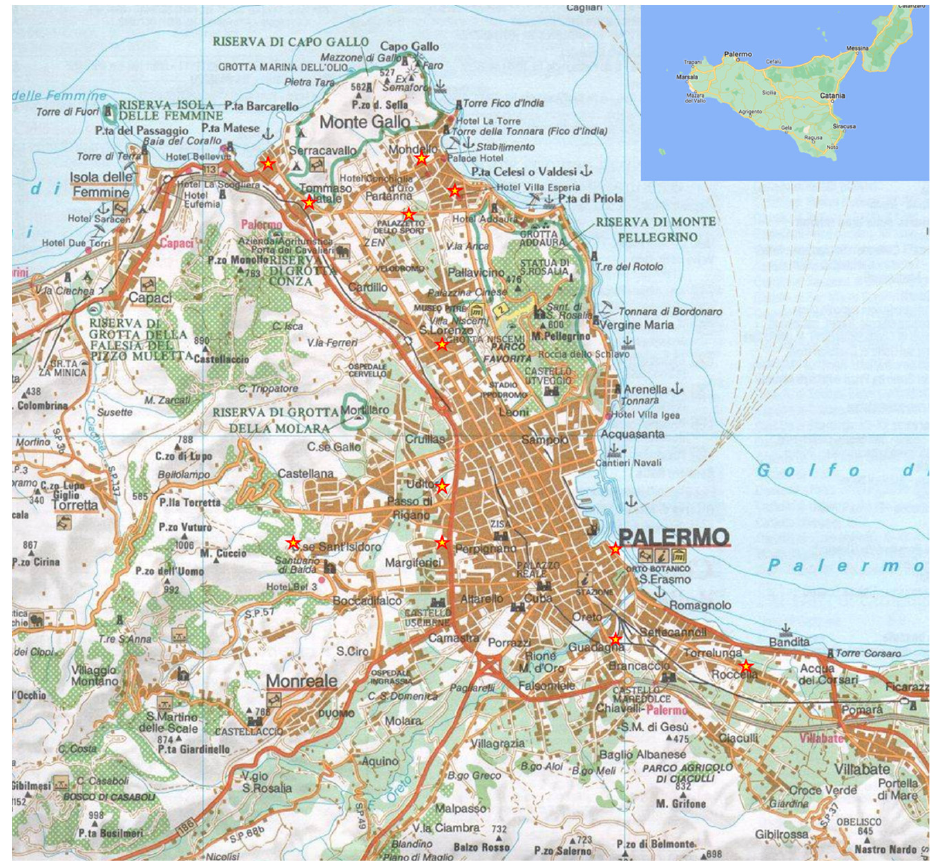
Figure 1. Map of study area. Symbols (yellow stars) indicate sampling localities.